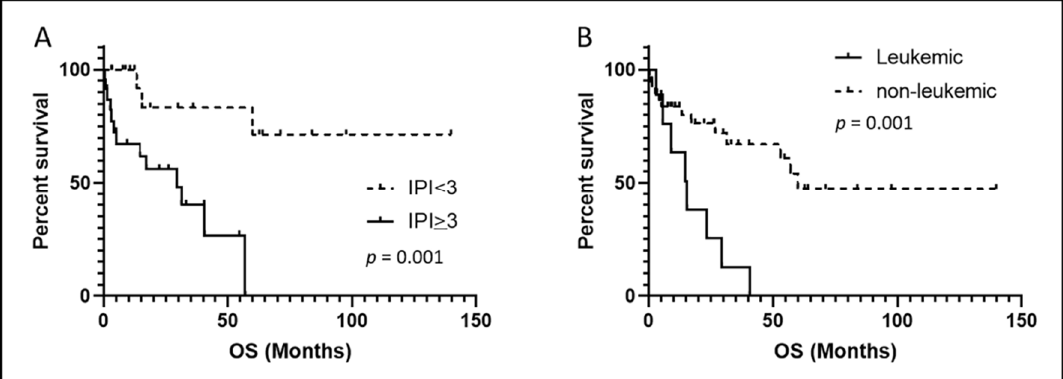
Figure 4. Overall survival (OS) analysis. ( A ), High IPI score (>3) was associated with shorter OS in all (leukemic and non-leukemic) ALK-negative ALCL patients. ( B ), The patients with leukemic ALK-negative ALCL had significantly shorter OS than the patients with non-leukemic disease. IPI, International prognostic Index.